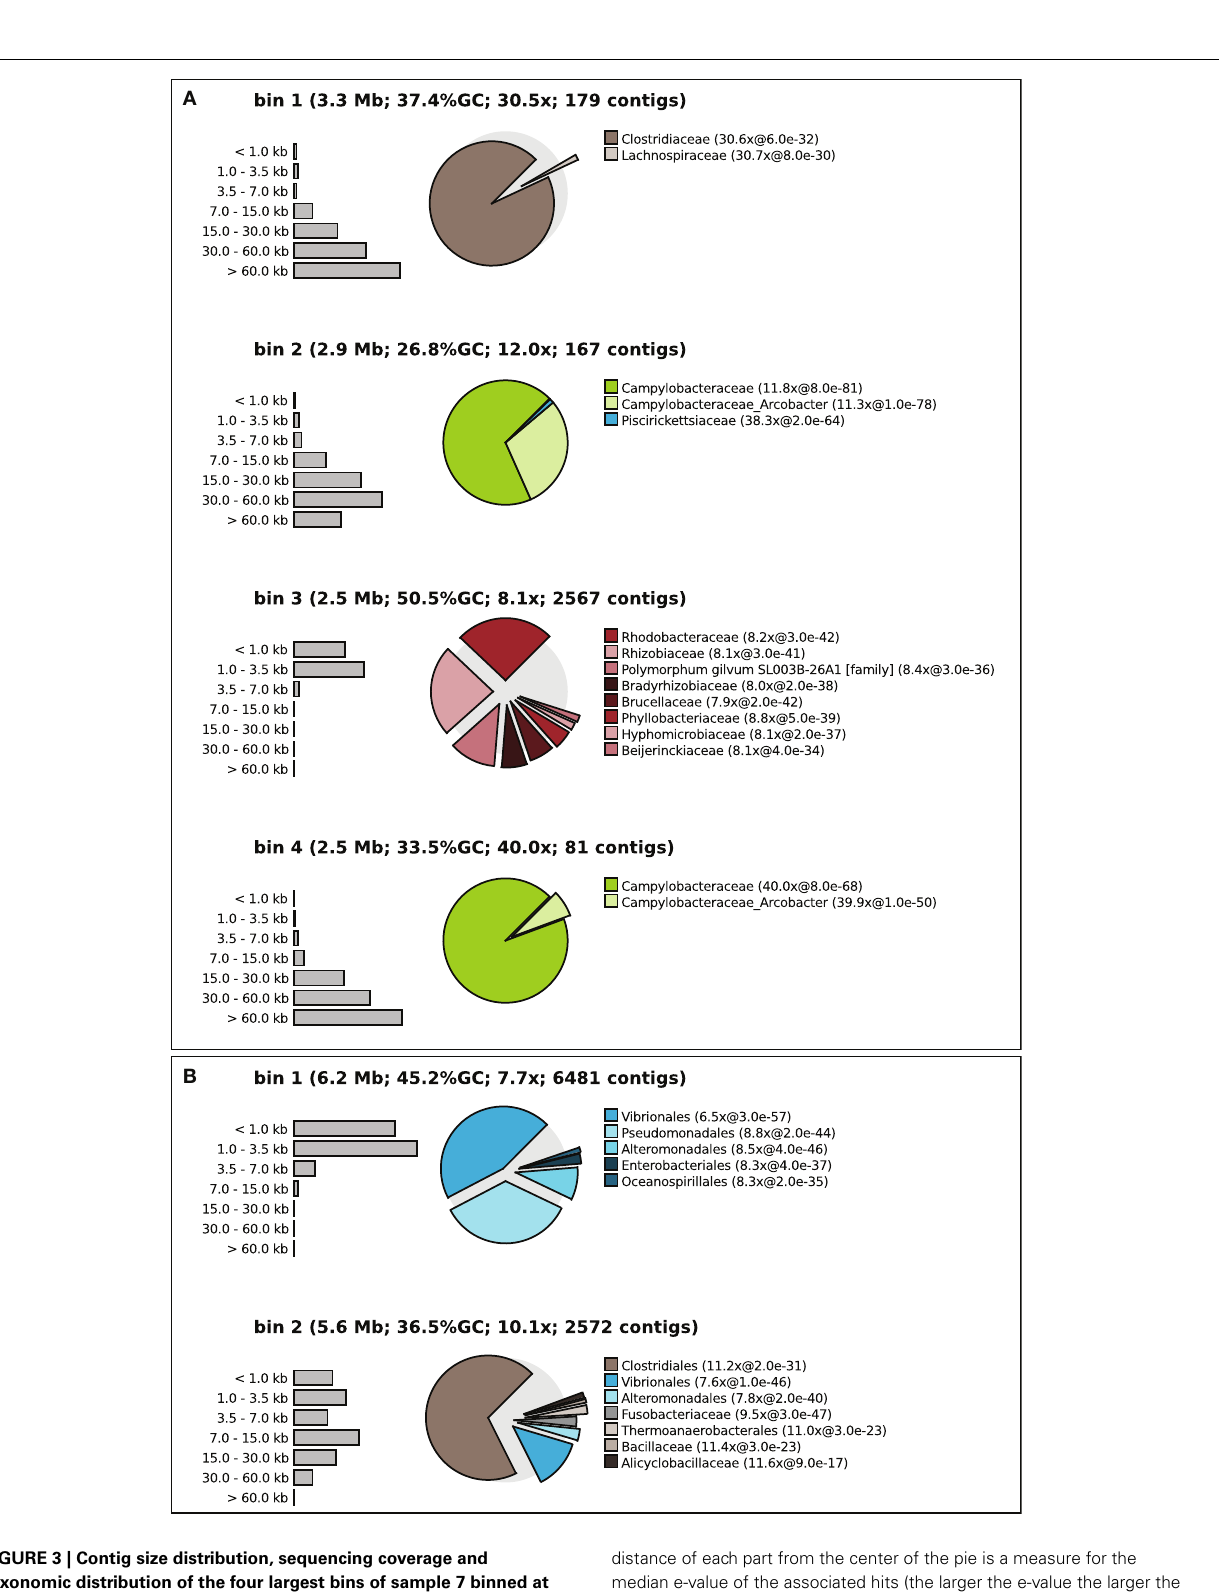
distance of each part from the center of the pie is a measure for the median e-value of the associated hits (the larger the e-value the larger the distance from the center). Coverage is shown for the bin as a whole and separately for each pie